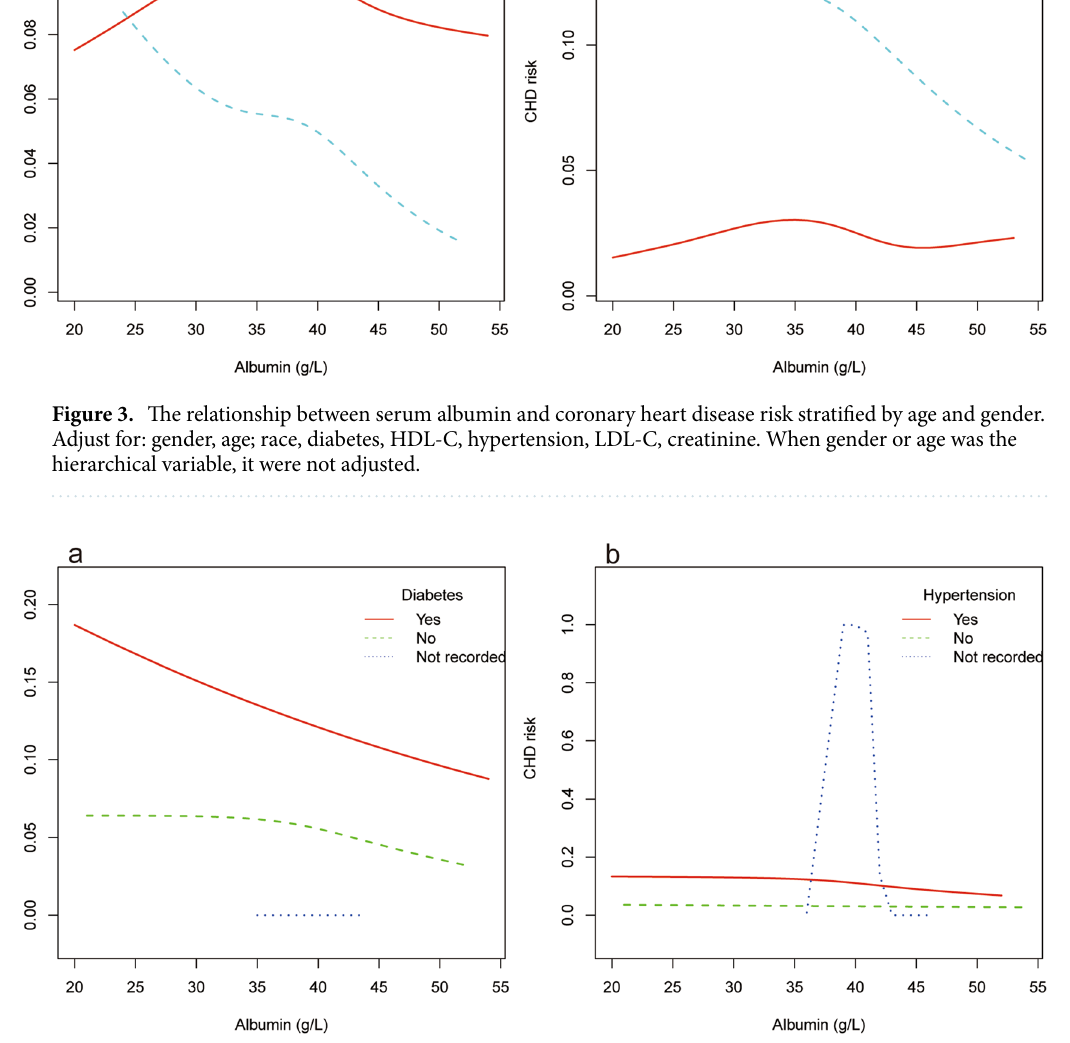
Figure 4. The relationship between serum albumin and coronary heart disease risk stratified by diabetes and hypertension. Adjust for: gender, age; race, diabetes, HDL-C, hypertension, LDL-C, creatinine. When diabetes or hypertension was the hierarchical variable, it was not